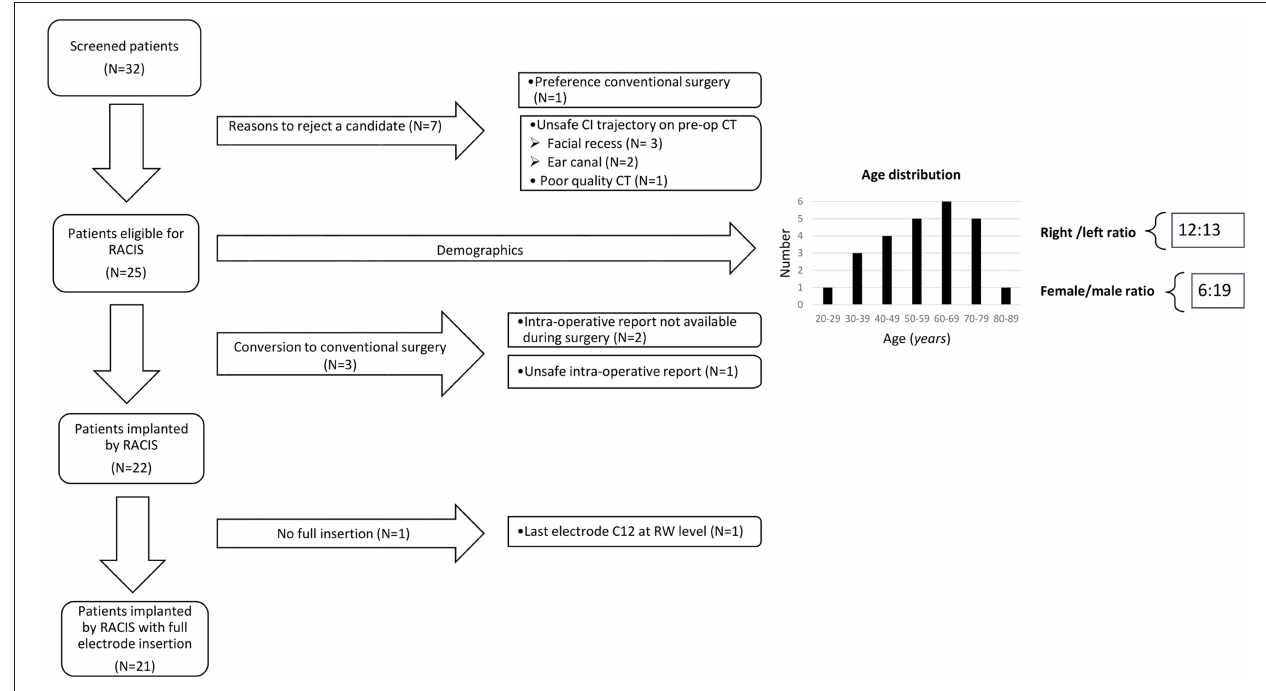
FIGURE 5 | Patient selection and demographics.